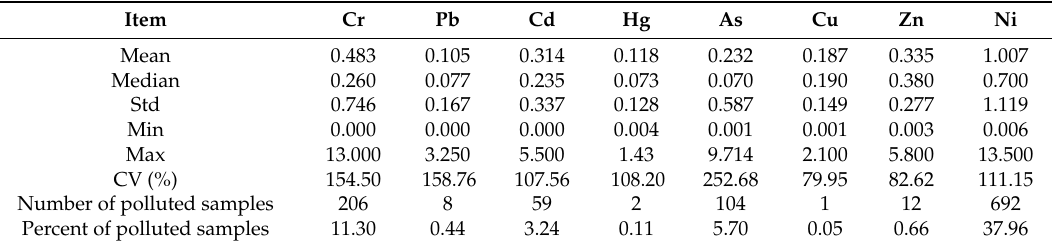
Table 8. Descriptive statistics of the crop pollution index (CPI) (mg/kg, N =